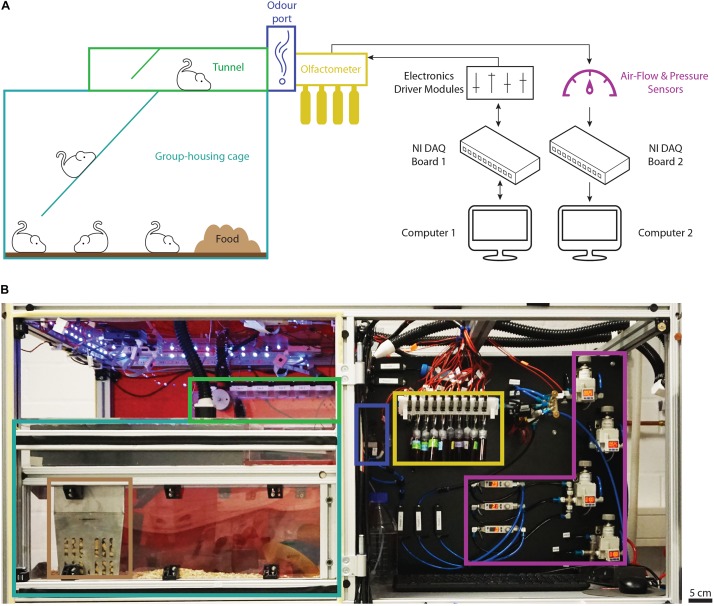
Overview of the automated behavior setup. (A) Schematic representation of the main components of the setup and their connections. The group-housing cage (light blue) is connected to the tunnel (green) via a ramp and provides the animals with food (brown) ad libitum. The odor port (dark blue) forms the end of the tunnel. Odors are presented from the custom olfactometer supplied with odor reservoirs (yellow) while the air flow is controlled and monitored by air-flow and pressure sensors (purple). Black arrows show the directionality of the main electronic connections to the data-acquisition and driver modules (black). (B) Photograph of the top half of the behavior setup with the main components highlighted as described in panel (A). Note that the front door shielding the housing area from the outside has been removed to provide a better overview. Computers and electronics driver modules are located in the bottom half of the setup not depicted in the photograph.